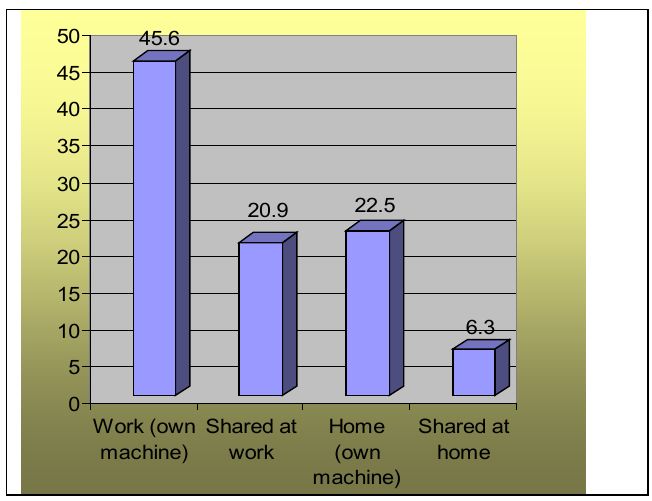
Figure 1 . Internet access